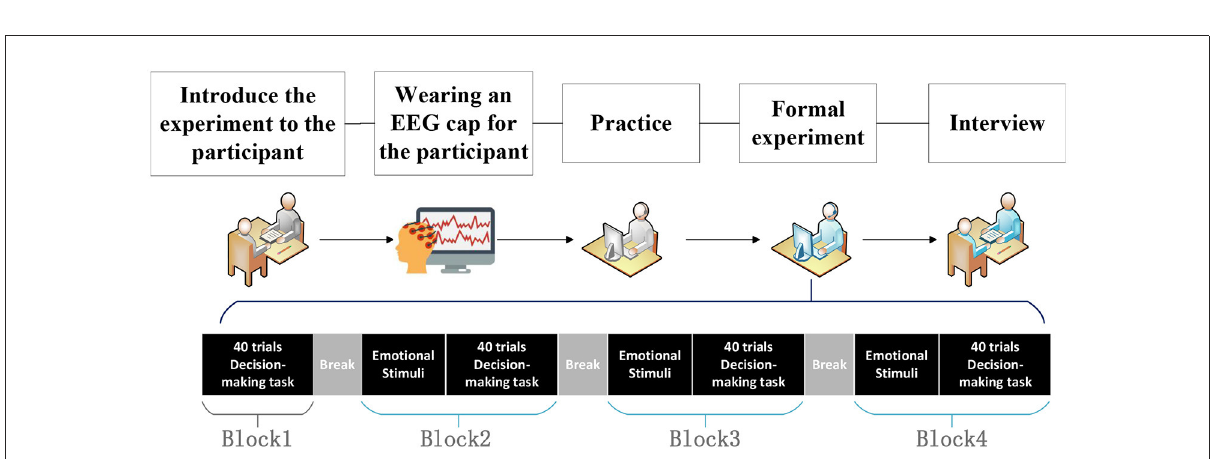
FIGURE4 Experimental procedure. At first, we introduced our experiment to subjects. Then, they were asked to wear an EEG cap to collect data. After this, they practiced the decision task. In the formal experiment, the subjects were asked to complete four blocks of decision task. Finally, they had an